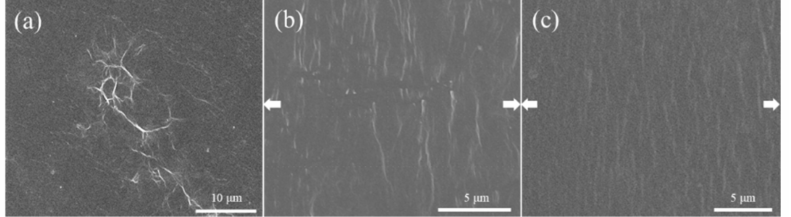
Figure 5. SEM surface images of the 30 laminated PDDA (GO)/PVA (MMT) layers on a stretchable substrate applying strains of ( a ) 0%, ( b ) 10%, and ( c ) 30%.